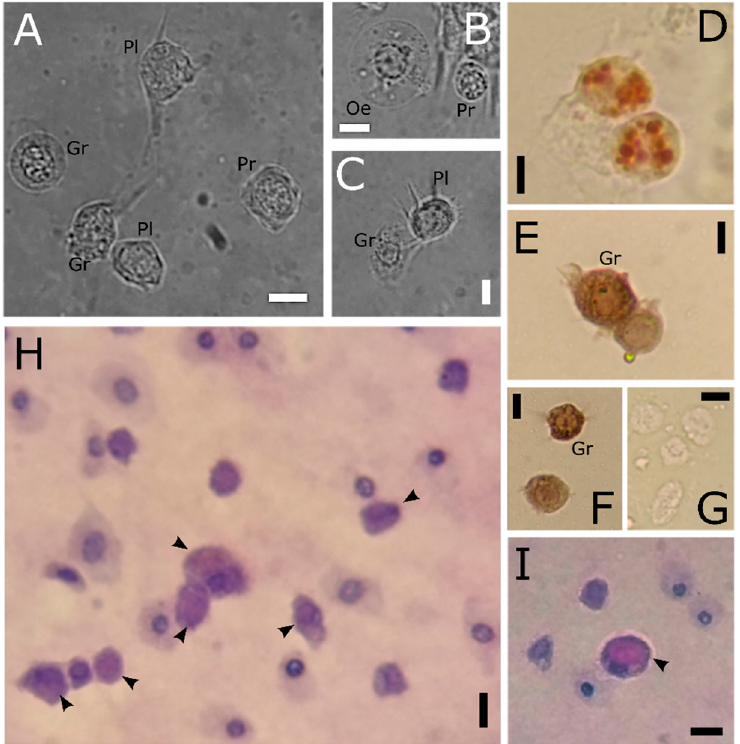
Figure 9. Light microscopy images of haemolymph smears from T. molitor . ( A – C ) In vivo haemocytes. ( D ) Haemocytes stained with neutral red to highlight lysosomes in red. ( E – G ) PO-haemocyte activity. Haemocytes showing cytoplasmic localisation of phenoloxidase in granular cells ( E , F ) and control ( G ). ( H , I ) PAS staining. Positive sites (arrowheads) indicating stored carbohydrates. Gr: granular cells; Oe: oenocytoids; Pl: plasmatocytes; Pr: prohaemocytes. Bars: 5 μ m.